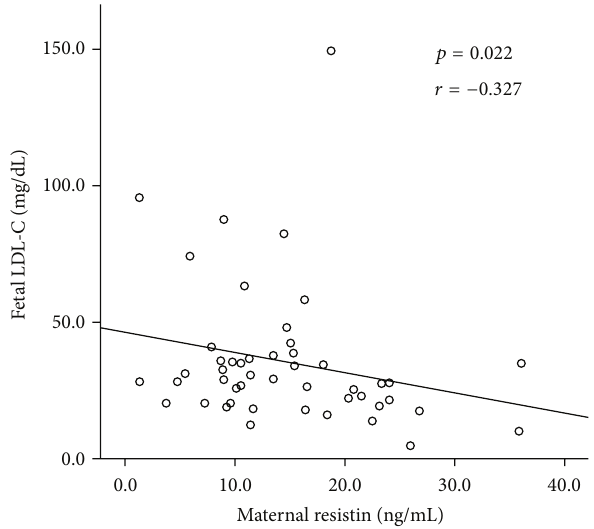
Figure 1: Correlation between circulating levels of maternal resistin and fetal